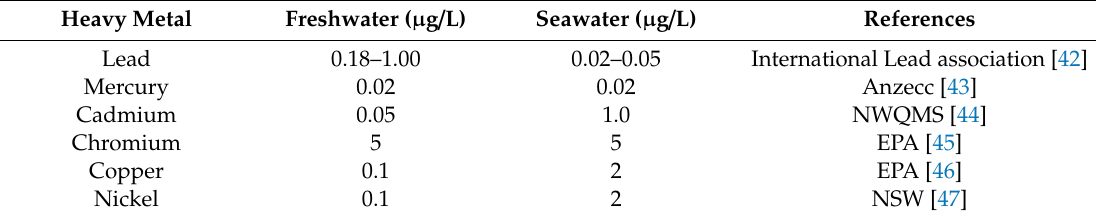
Table 1. The most common permissible limits of heavy metals in aquatic environments for fish